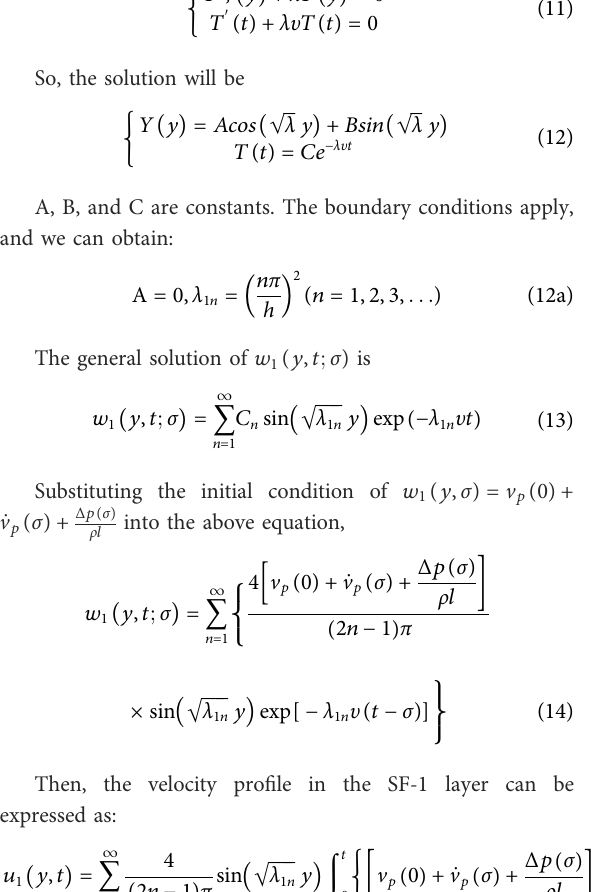
TABLE 1 Parameters of MR fl